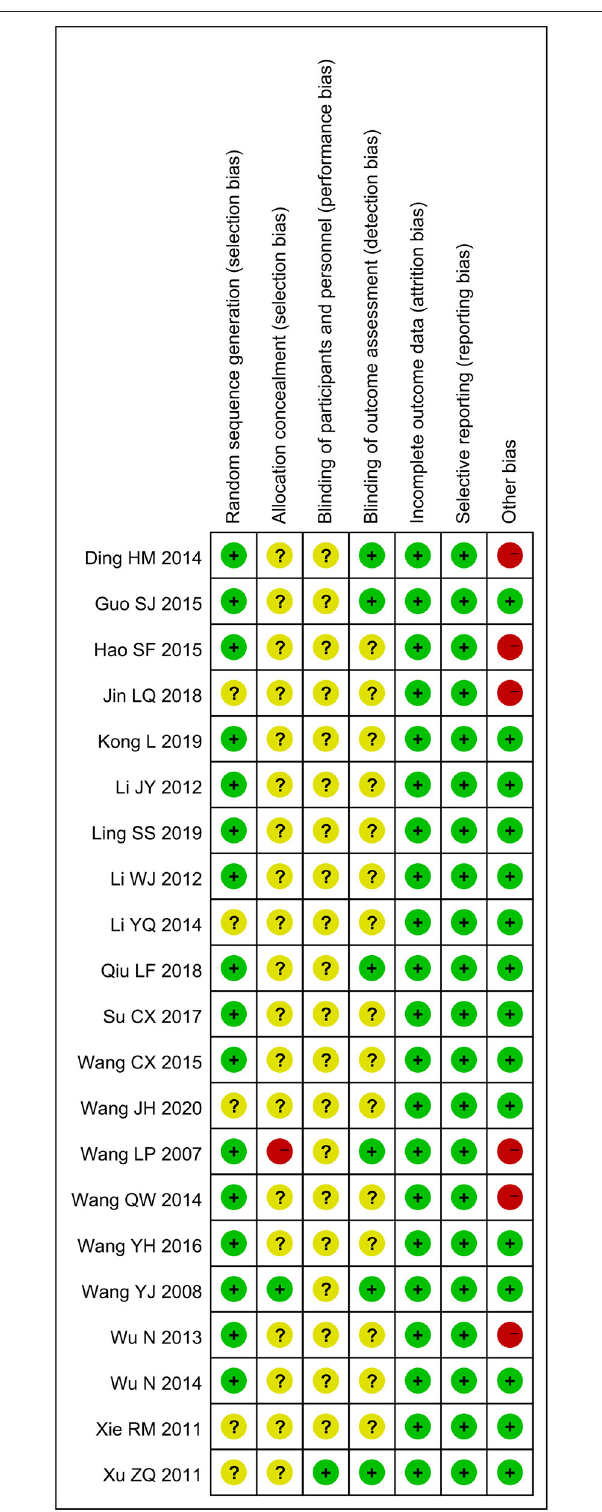
FIGURE 2 | Risk of bias assessments of included